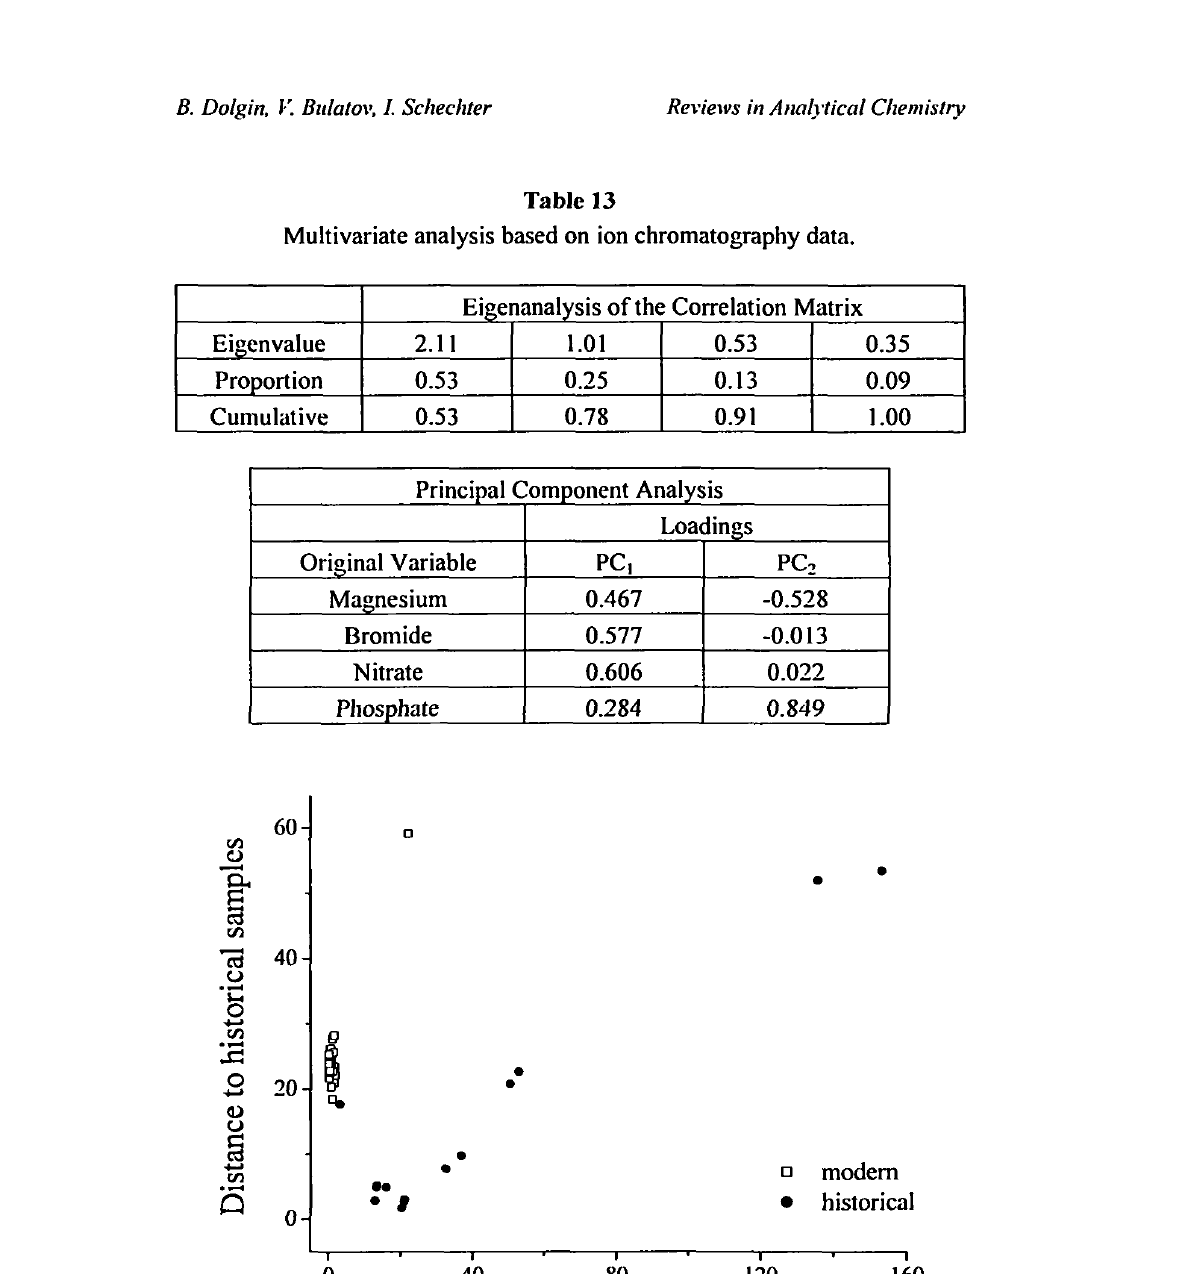
Fig. 68: Discriminant analysis of the parchment samples based in ion Chromatographie